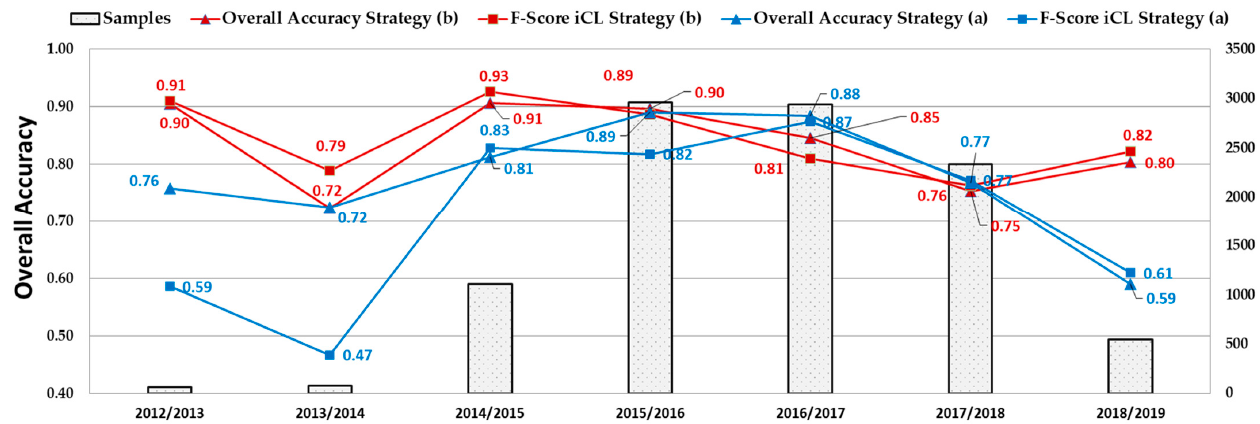
Figure 8. Overall accuracy and F-score of the iCL class obtained for each year and for the two temporal